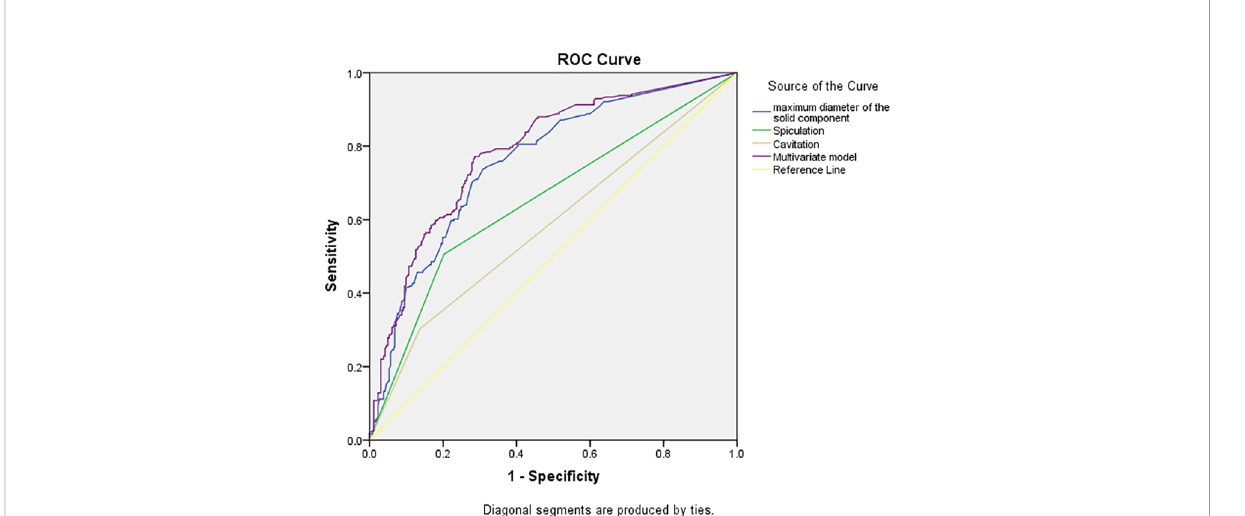
FIGURE 3 Receiver operating characteristic curves of independent predictors and multivariate model of spread through air space (STAS). The area under the curve of the multivariate model was 0.785 (95% con fi dence interval: 0.745 – 0.825, P <